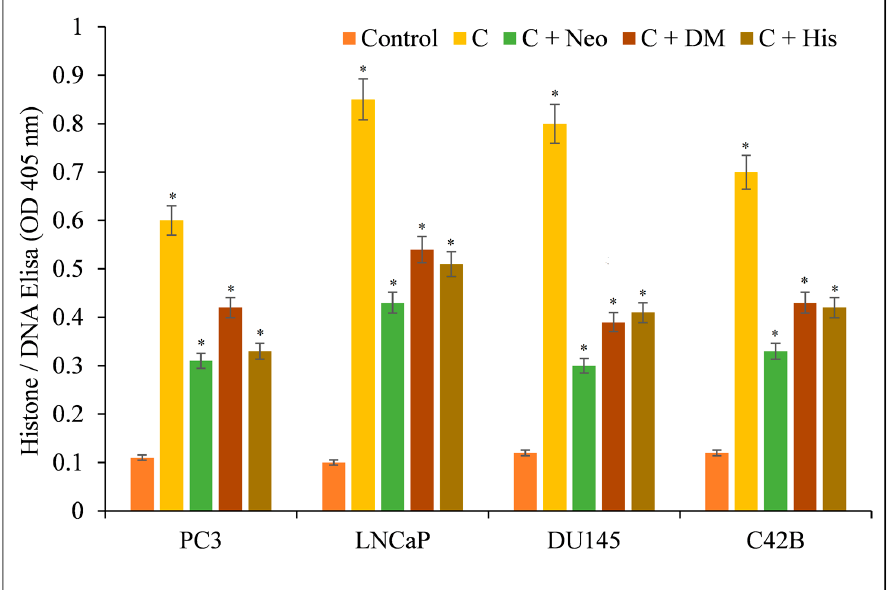
Figure 6. Effects of various metal chelators on the induction of apoptosis by curcumin in four distinct cancer cell lines. As depicted in the image, PC3, LNCaP, DU145, and C42B cancer cells were treated with 25 μ M of curcumin alone or in the presence of the copper chelator neocuproine (Neo), the iron chelator desferrioxamine mesylate (DM), or the zinc chelator histidine (His). The concentration of metal chelators utilized was 50 µ M. After 72 h of treatment as specified in Section 2, ELISA was performed. The stated values are the ± S.E.M. of three separate experiments. * p value < 0.05 in comparison to the control